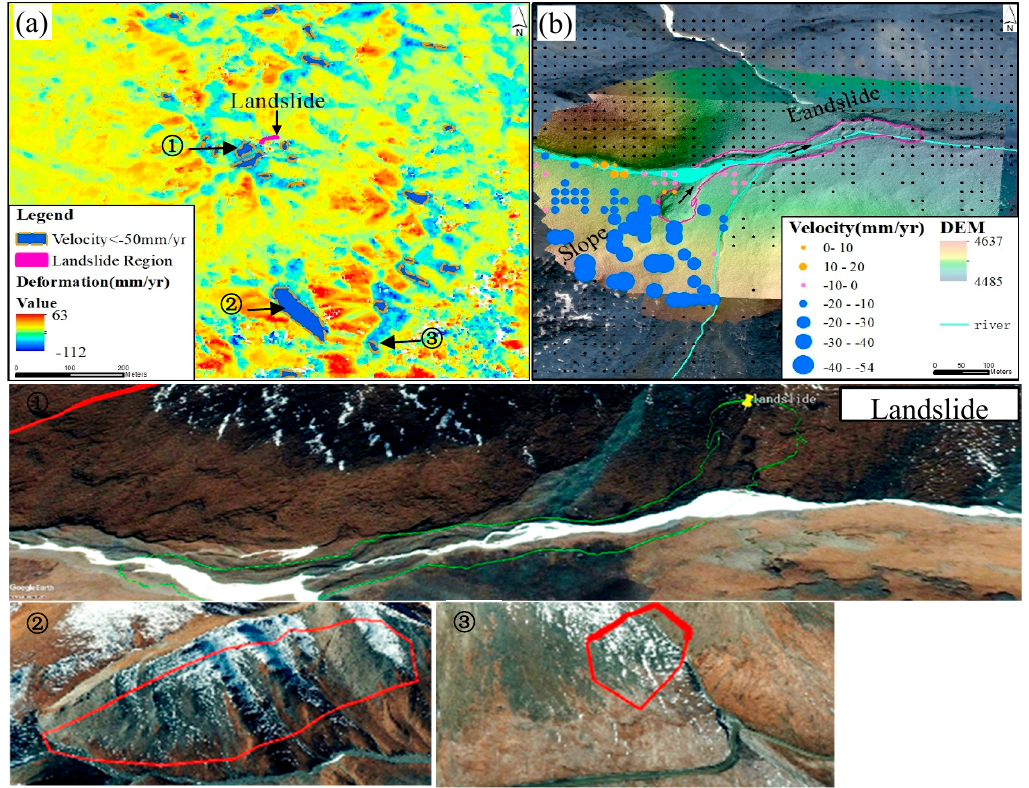
Figure 3. The vertical deformation velocity (VDV, mm/year) of the region based on the ( a ) pixels and the ( b ) point. The arrows indicate the direction of landslide flow in the DEM (30 cm x 30 cm) detected by the UAV. ① , ② and ③ are the fast creep (> 50 mm/yr) regions in Google Earth.